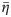
Human evaluation of confinement.Plateau recommendations for seed videos stemming from region 1 (largest entropy η¯) are generally perceived as most similar (five stars), while the opposite holds for region 3. Region 2 appears as a middle way.